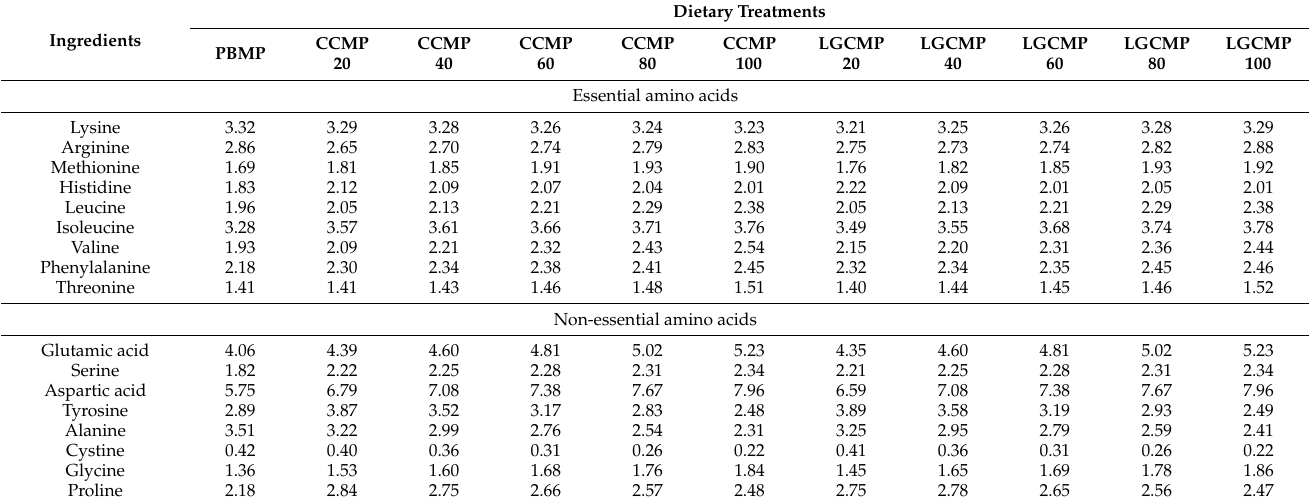
Table 2. Amino acid compositions (dry matter basis, %) of experimental